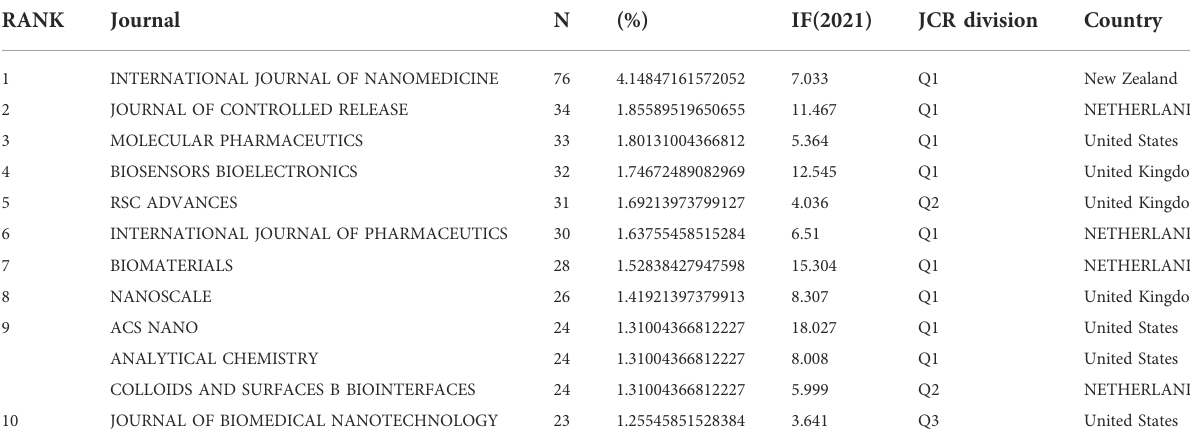
TABLE 1 The top 10 journals of Nanoparticles-leukemia-related research.